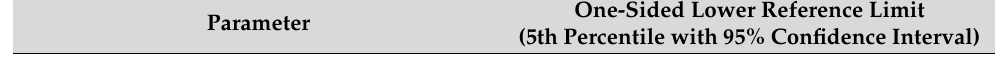
Table 4. WHO Semen Analysis